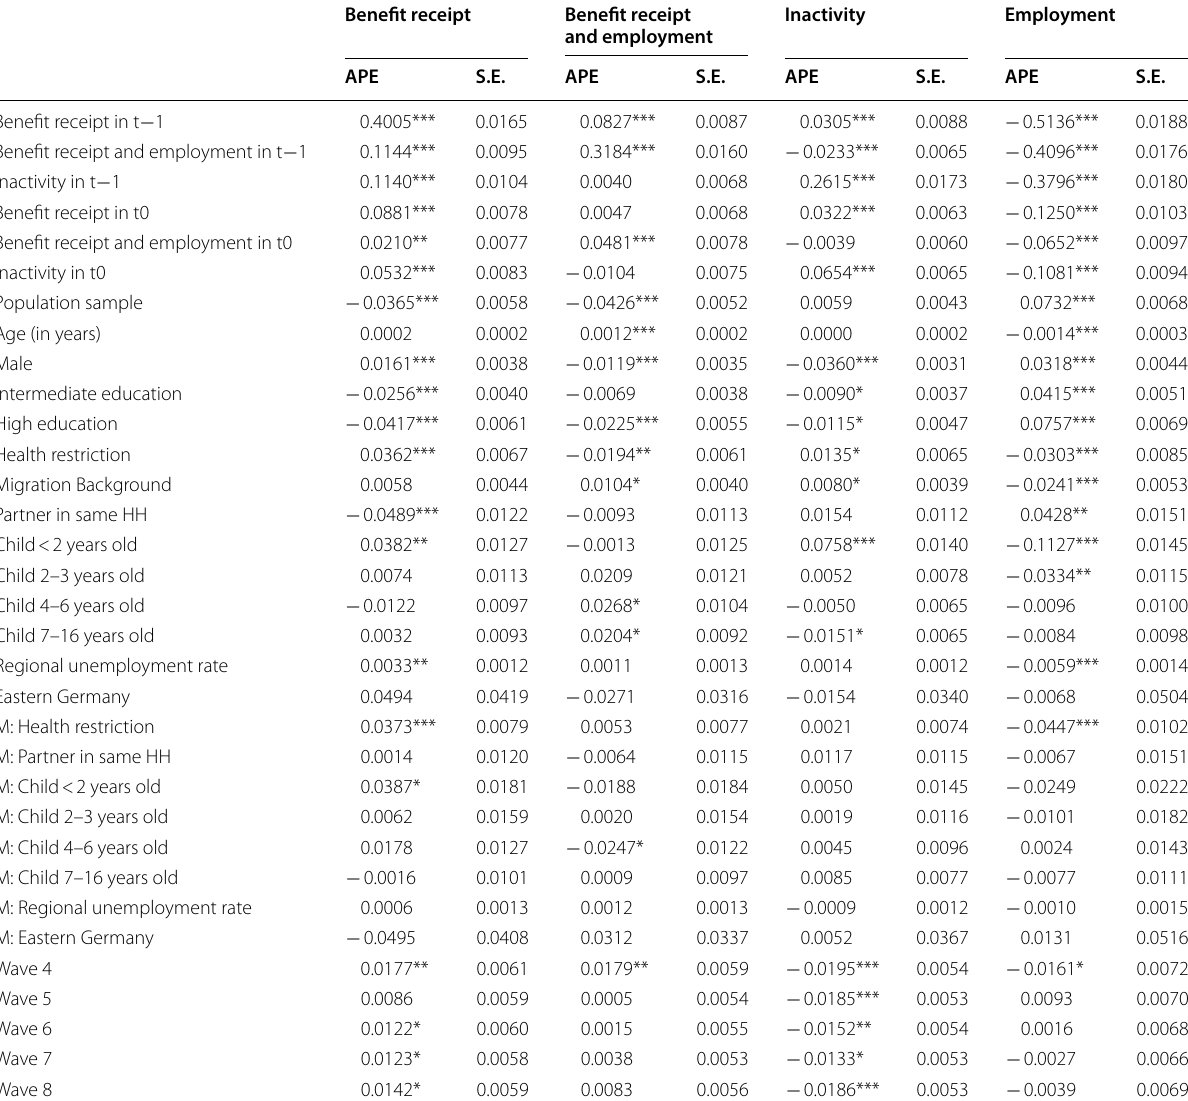
Table 15 Average partial effects of all explanatory variables on the probability to be in a given state in t (PASS including individuals without consent to data linkage or not found in administrative